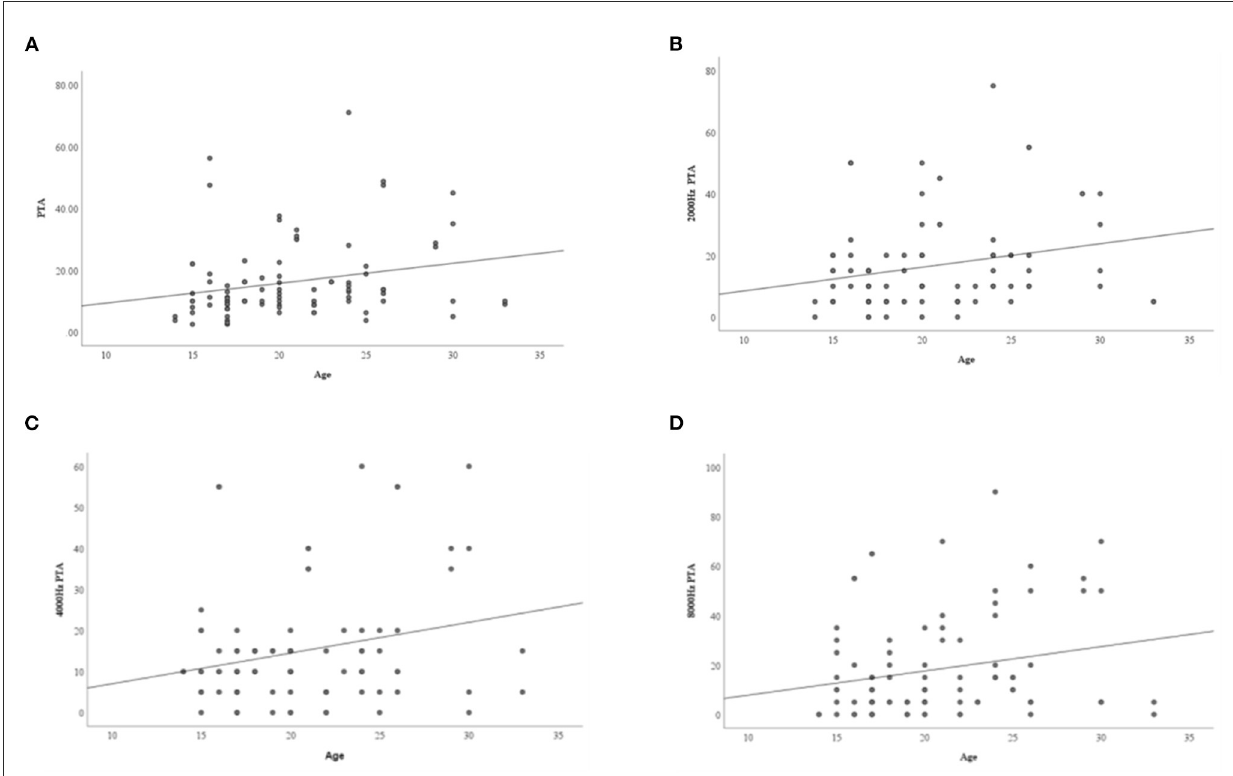
FIGURE1 The relationship between age and PTA at different frequencies. (A) Average hearing threshold increases with age; (B) 2,000Hz hearing threshold increases with age; (C) 4,000Hz hearing threshold increases with age; (D) 8,000Hz hearing threshold increases with age.